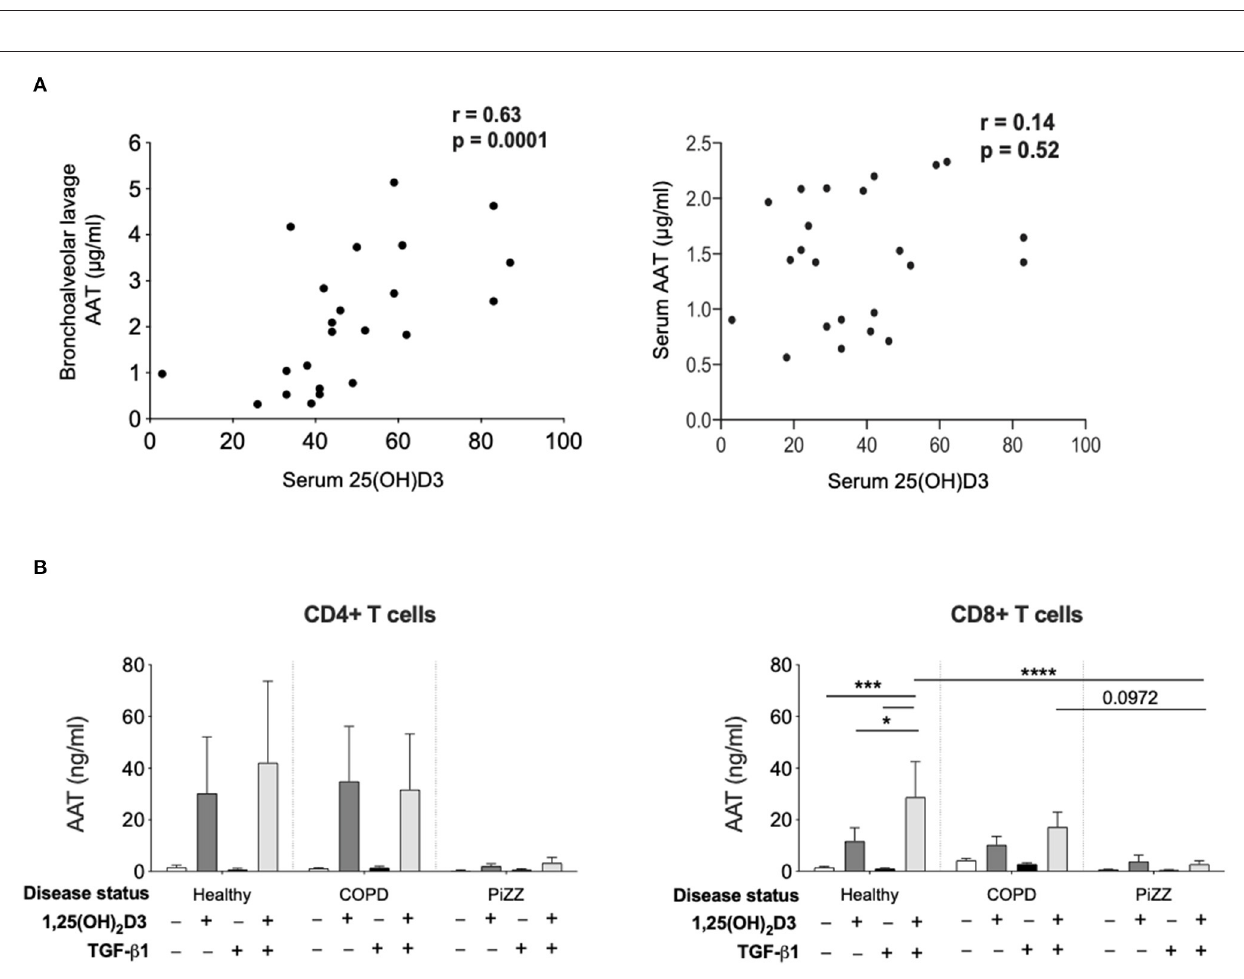
FIGURE 5 | Patient studies to assess in vivo relevance. (A) Serum concentration of 25(OH)D3, as well as bronchoalveolar lavage (left) and serum (right) concentration of AAT were assessed in a paediatric severe asthma cohort and in paediatric controls undergoing bronchoscopy. Correlations were assessed using Spearman’s rank correlation. (B) CD4 + and CD8 + T cells were isolated from the peripheral blood of healthy donors (CD4 + n = 6, CD8 + n = 12), non-AAT deficient COPD ( n = 9) and PiZZ patients (CD4 + n = 6, CD8 + n = 20) and cultured for 7 days in the absence (–) or presence of 1,25(OH) 2 D3 (100nM) with or without TGF- β 1 (2ng/ml) before culture supernatants were assessed for AAT protein secretion by ELISA. Data are expressed as mean ± SEM and statistical analysis employed a 2-way ANOVA with Bonferroni multiple comparison test with * p < 0.05, *** p < 0.001, **** p <